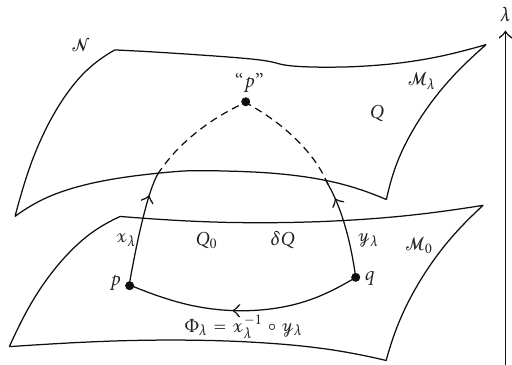
Figure 2: The second-kind gauge is a point-identification between the physical spacetime M λ and the background spacetime M 0 on the extended manifold N . Through (5), we implicitly assume the existence of a point-identification map between M λ and M 0 . However, this point-identification is not unique by virtue of the general covariance in the theory. We may chose the gauge of the second-kind so that p ∈ M 0 and “ p ” ∈ M λ is same ( X λ ).